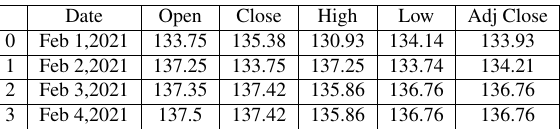
Table 1. A sample of input